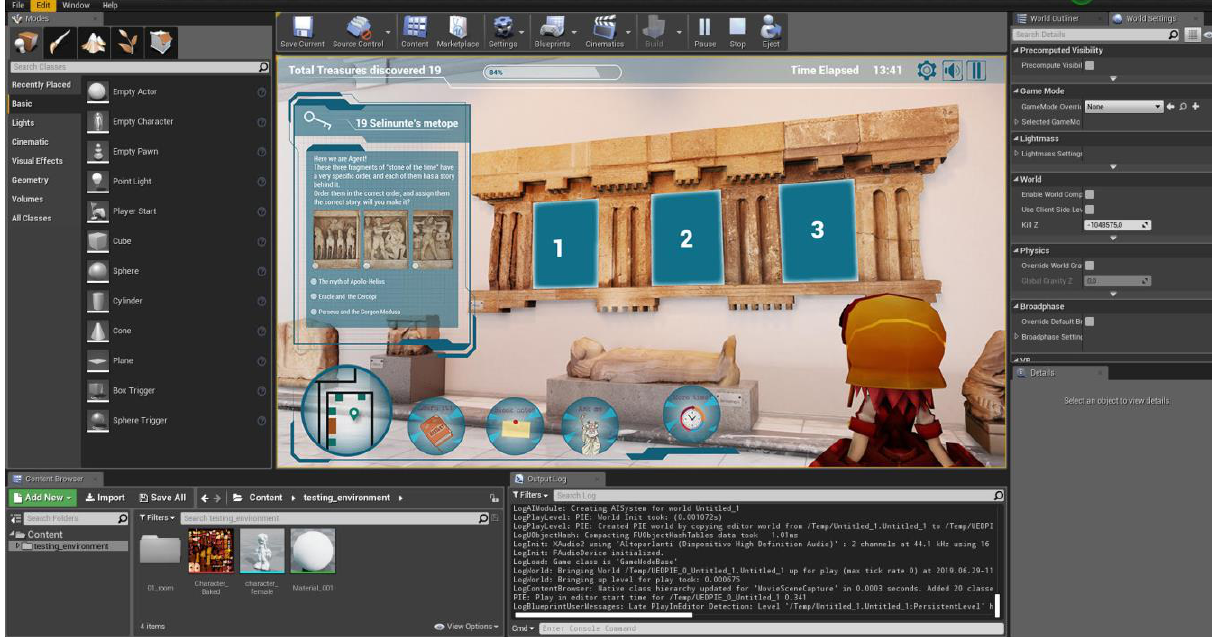
Figure 6. Game environment and play modality for young target audience. Configuration of the context and of the player's paths within the UnReal Engine 4 platform . Design of the selection and interaction modalities of the contents within the UnReal Engine 4 platform .